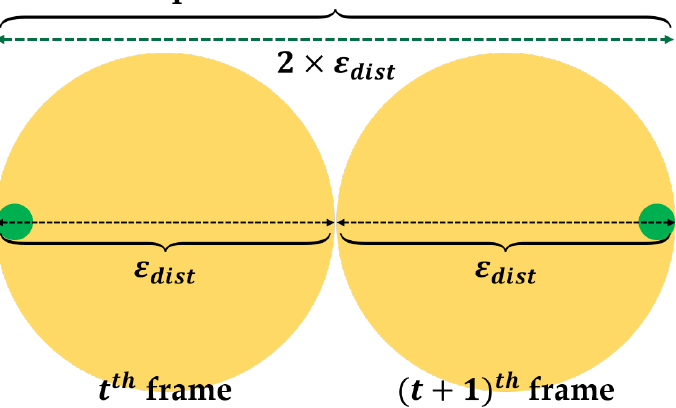
Figure 12. Speed tolerance based on maximum potential distance tolerance.